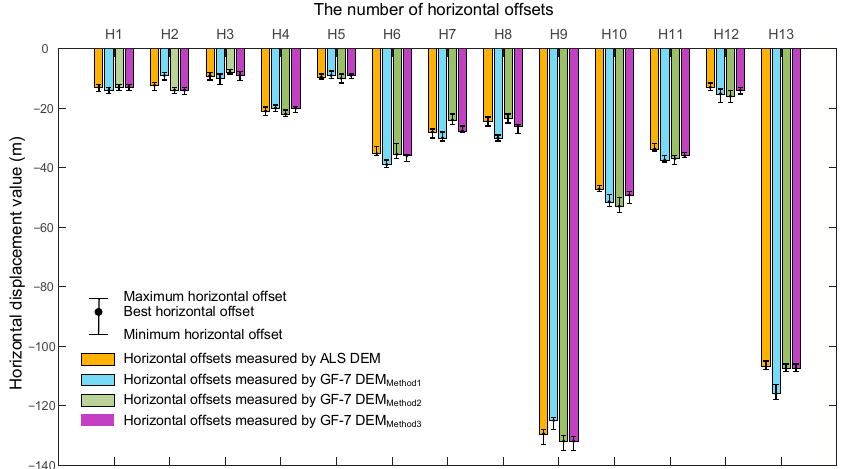
The number of horizontal offsets